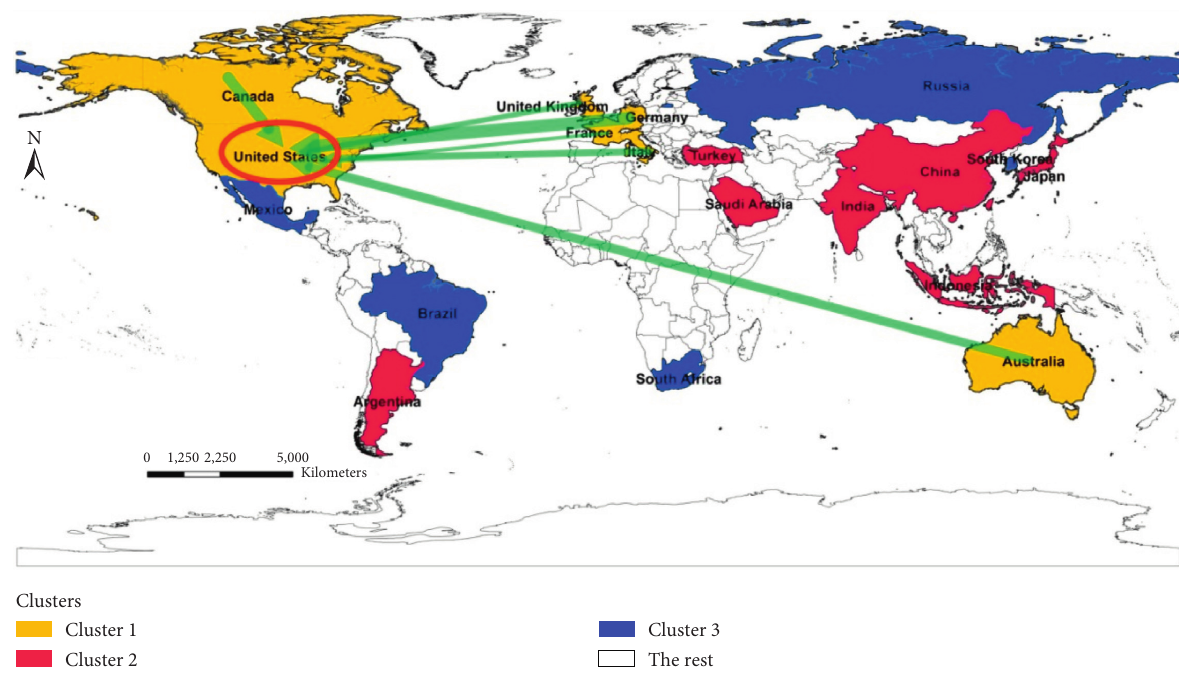
Figure 7: The volatility spillovers from DAX (Germany), CAC 40 (France), FTSE 100 (UK), MIB (Italy), TSX (Canada), and All Ordinaries (Australia) to S&P 500 (US).